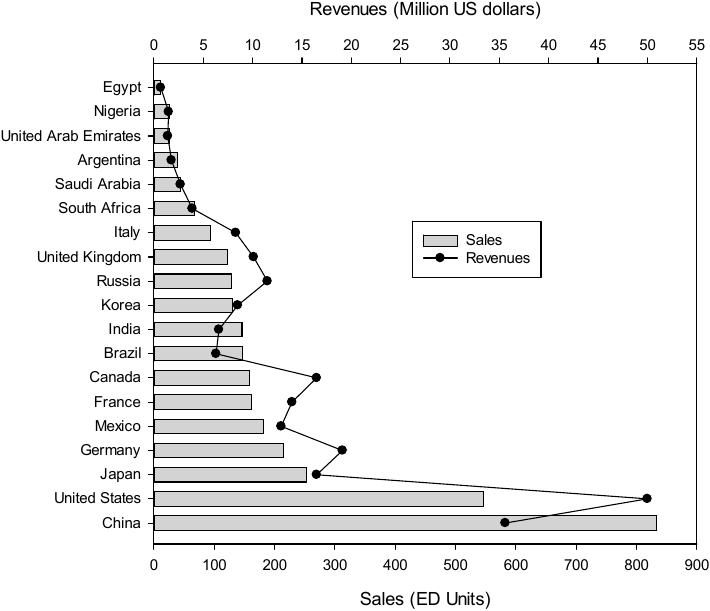
Figure 2. Forecast sales (in number of conventional electrodialysis Units) and revenues (in million US dollars) by countries for 2020.